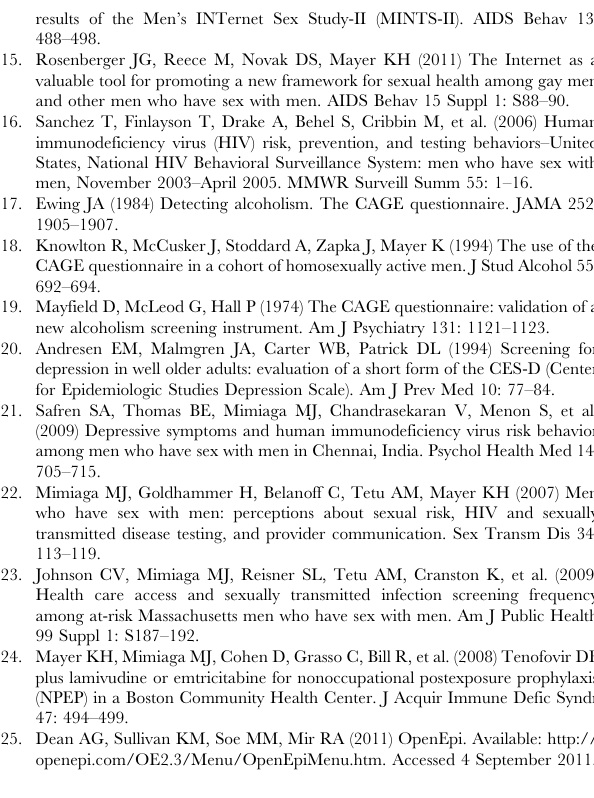
Gender of Sex Partners - prior 3 mo. Men only